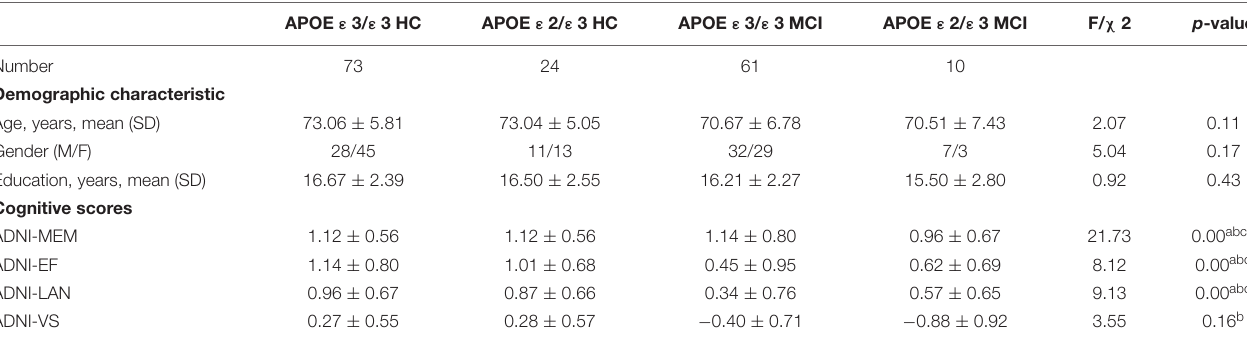
TABLE 1 | Demographic characteristics and cognitive scores of the study